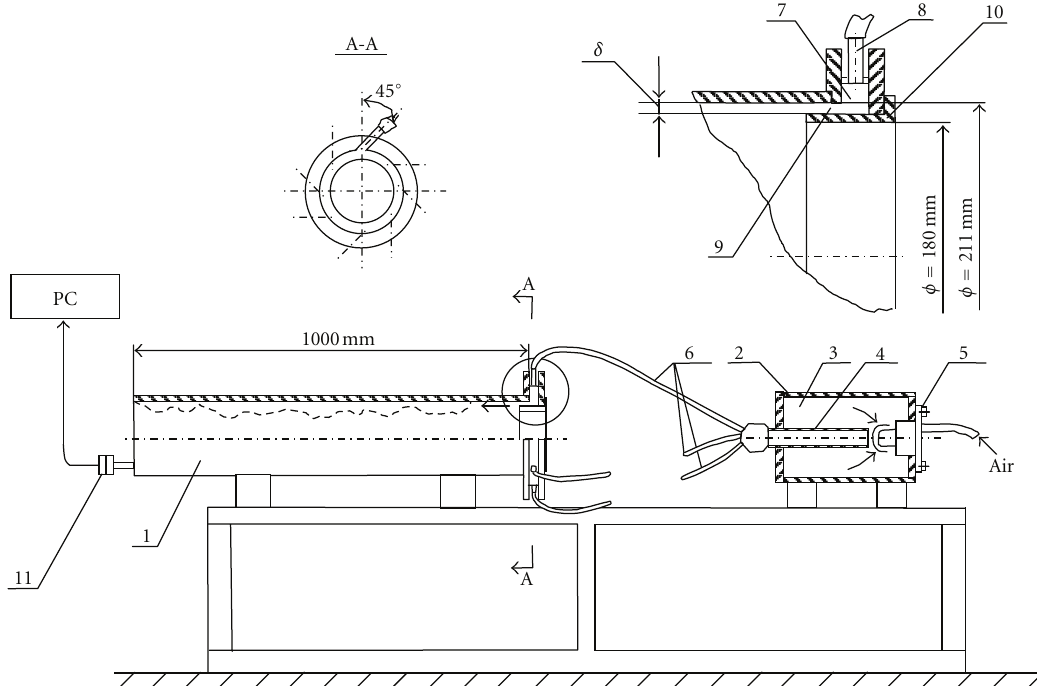
Figure 10: The experimental setup. (1) model of a chemical reactor, (2) pnevmopulse generator, (3) storage chamber, (4) exhaust nozzle, (5) high-speed valve, (6) rubber hose, (7) circular prechamber, (8) fitting, (9) slotted nozzle, (10) the input cylinder, and (11) total pressure probe.